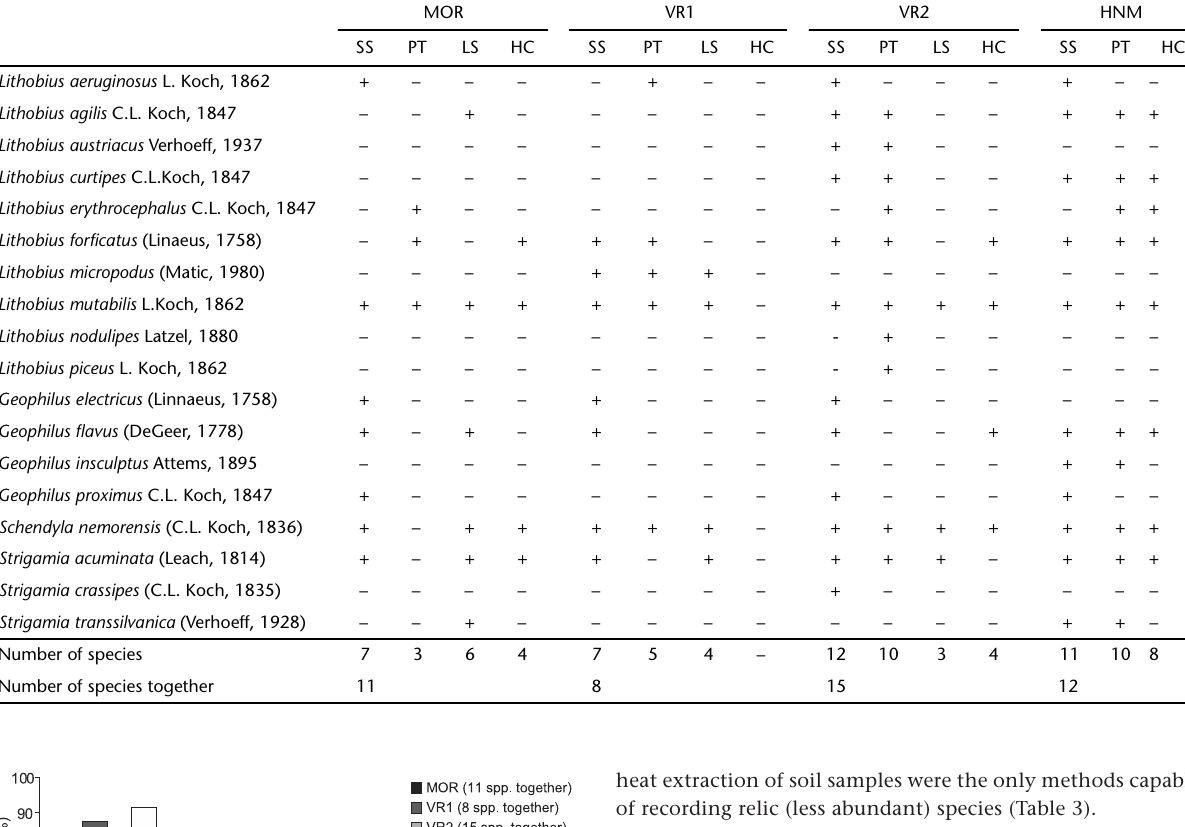
Table 1. Species spectrum recorded by individual methods on studied localities. Methods: (SS) soil sampling, (PT) pitfall trapping, (LS) litter sifting, (HC) hand collecting.